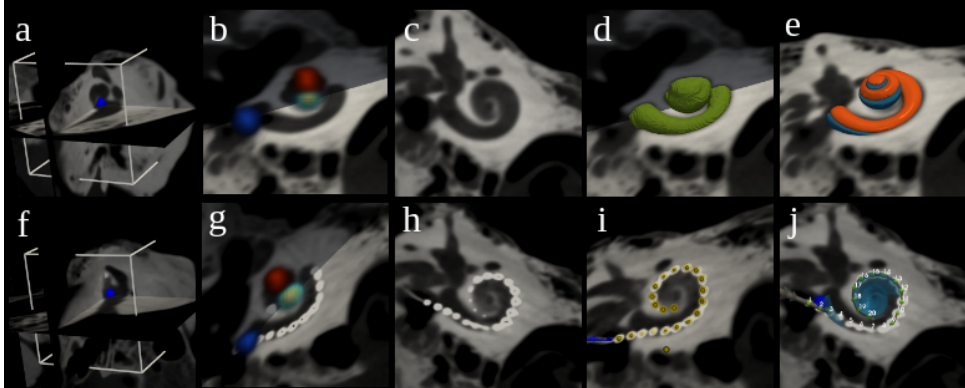
Figure 3. Steps of the image analysis pipeline in Nautilus. Regions of interest (10 × 10 × 10 mm) around a manually placed center (blue sphere) are cropped from both pre-operative ( a ) and post-operative ( f ) images. Landmark heatmaps are estimated ( b , g ) for the center (green), round window (blue), and apex (red). Images are aligned with rigid registration ( c , h ) as shown in cochlear view. Segmentation of the cochlear bony labyrinth (CO) ( d ) is subsequently split into the scala tympani (ST) and scala vestibuli (SV) ( e ). From the post-operative image, electrode array contact coordinates and lead wire are extracted ( i ), and an Oticon Medical EVO electrode CAD model is fit ( j